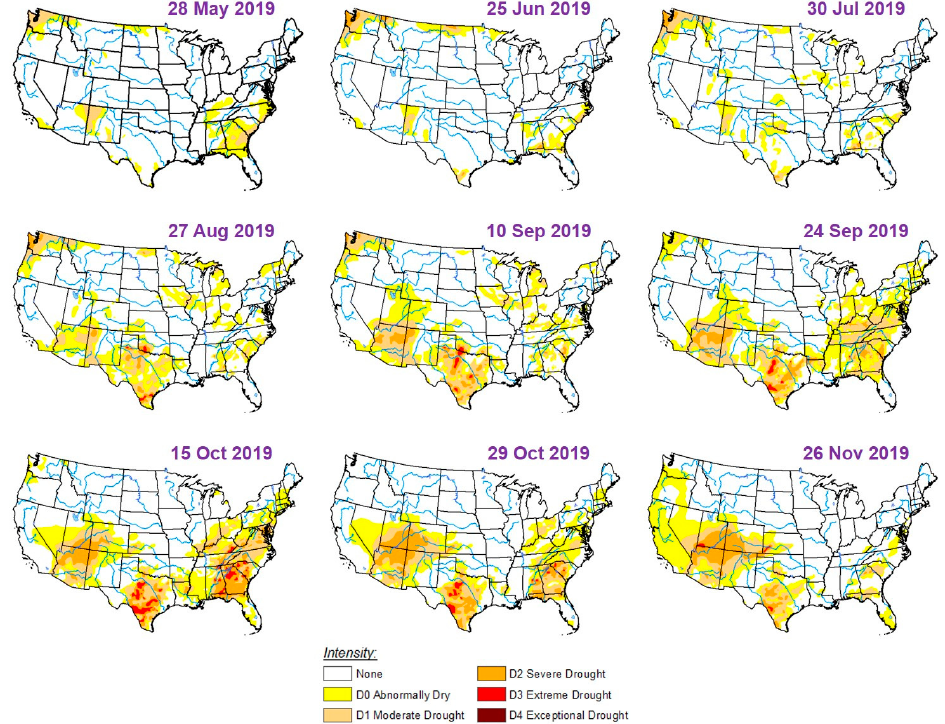
Figure 9. Selected U.S. Drought Monitor maps from May to November